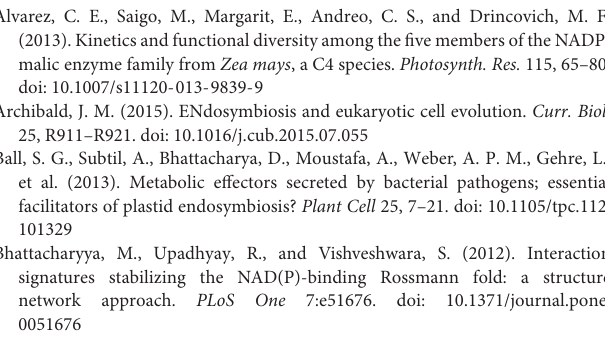
FIGURE S2 | Co-evolutionary residue positions of plant mNAD-MEs. (A) Circos representation for co-evolutionary residue positions of α and β mNAD-MEs. Labels in the first and second circles indicate the amino acid number of the α -mNAD-ME from A. thaliana . Colored square boxes of the third circle indicate the multiple